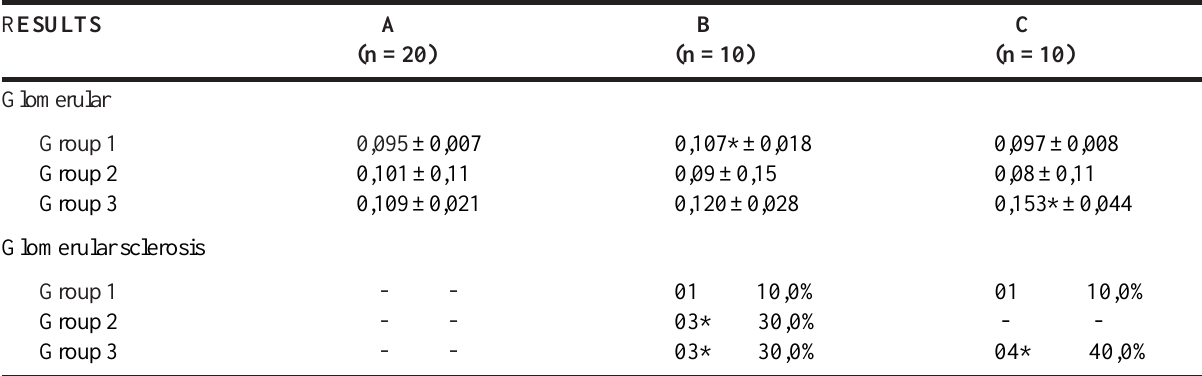
TABLE 4 - Histological results